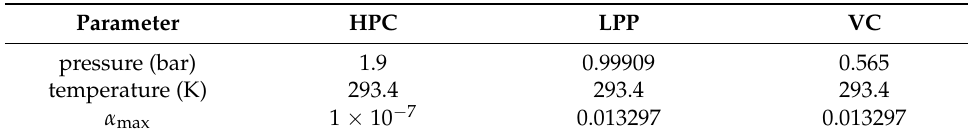
Table 1. The initial parameters in each region.